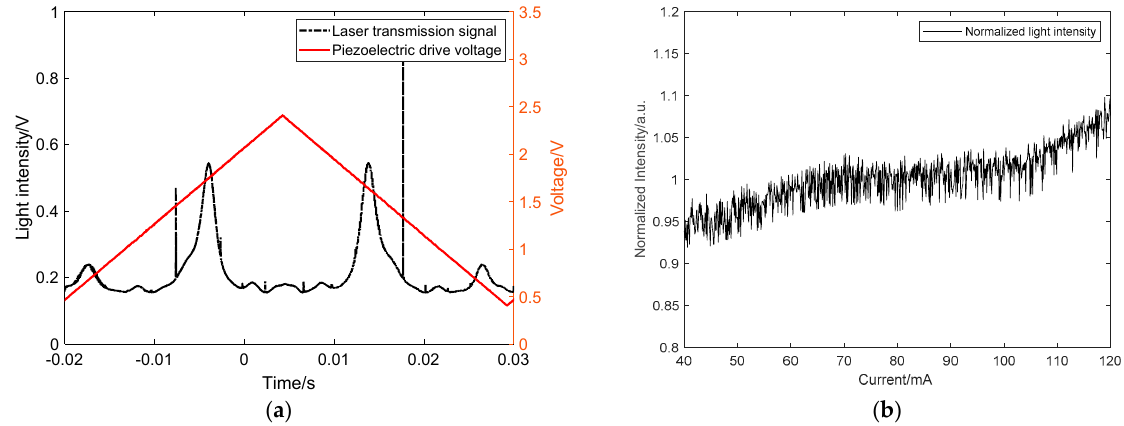
Figure 2. Resonant modes separation phenomenon and the corresponding spectral signal. ( a ) The resonant modes separation phenomenon; ( b ) The corresponding cavity-enhanced absorption spectrum.